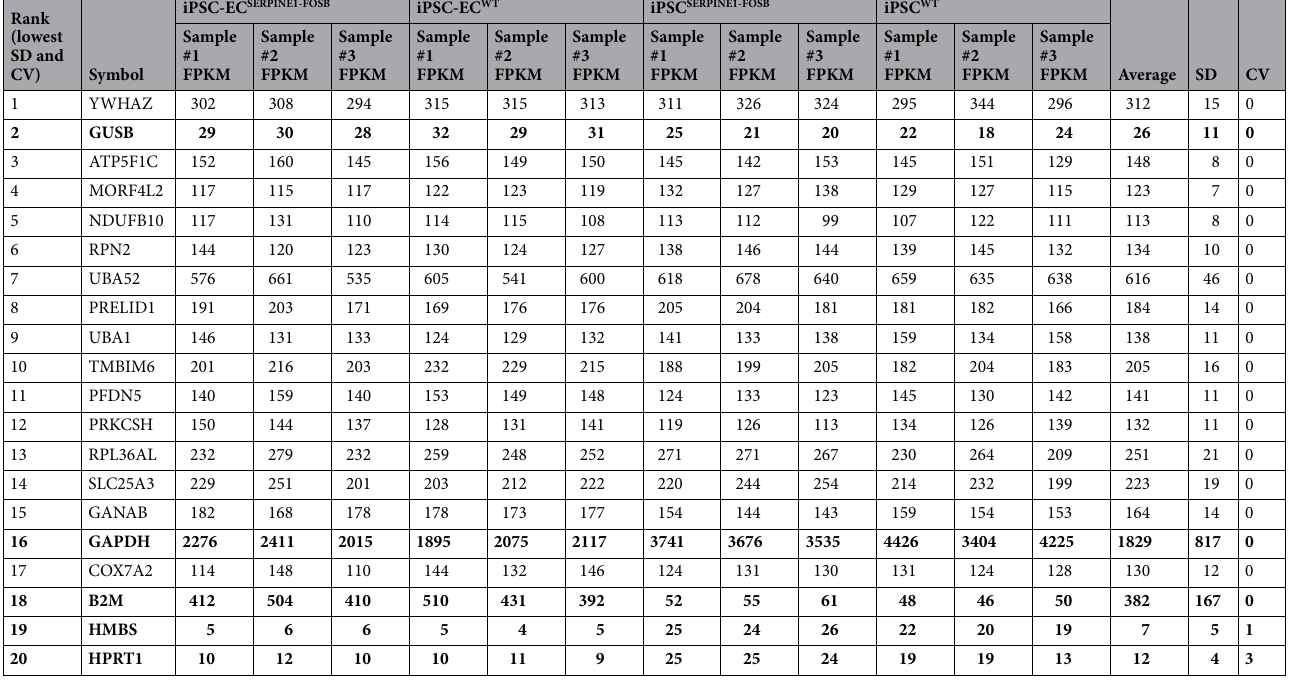
Table 1. Transcriptome values of housekeeping genes. Common housekeeping genes that were added into our study are highlighted in